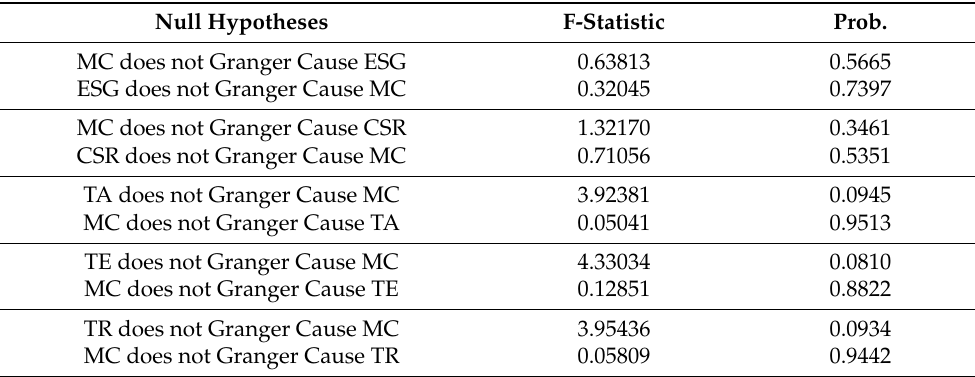
Table 4. Pairwise Granger causality